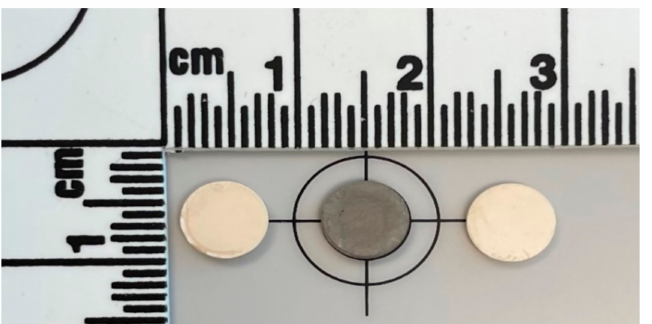
Figure 1. Appearance of 10GDC control pellet sintered at 1600 ◦ C for 10 h ( left ), one sintered under 4% H 2 -N 2 at 1100 ◦ C for 20 h ( center ) and one following re-oxidation ( right